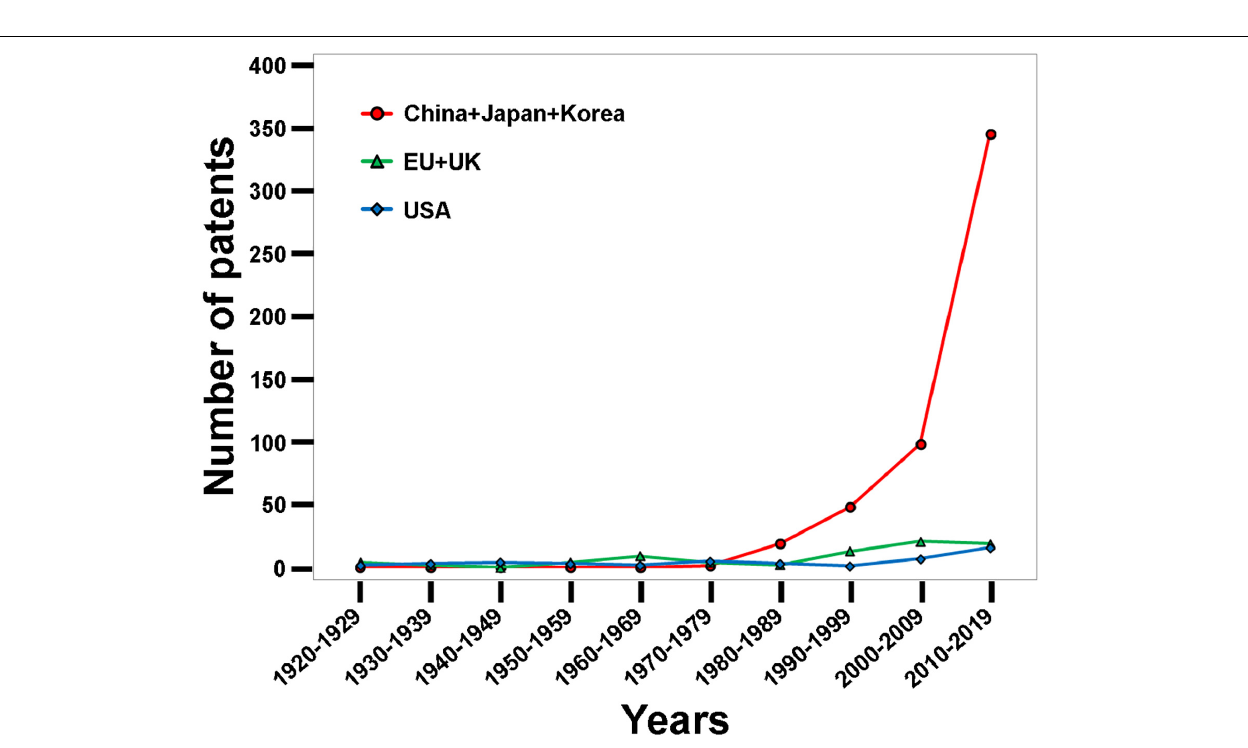
FIGURE 3 | Geographic distribution of ES patents in the last century amongst different countries, showing the recent dramatic output from Asian countries (China, Japan, Korea, and Taiwan), which is responsible for the observed exponential increase in patent numbers over the last two decades (Data derived from the Google patent research